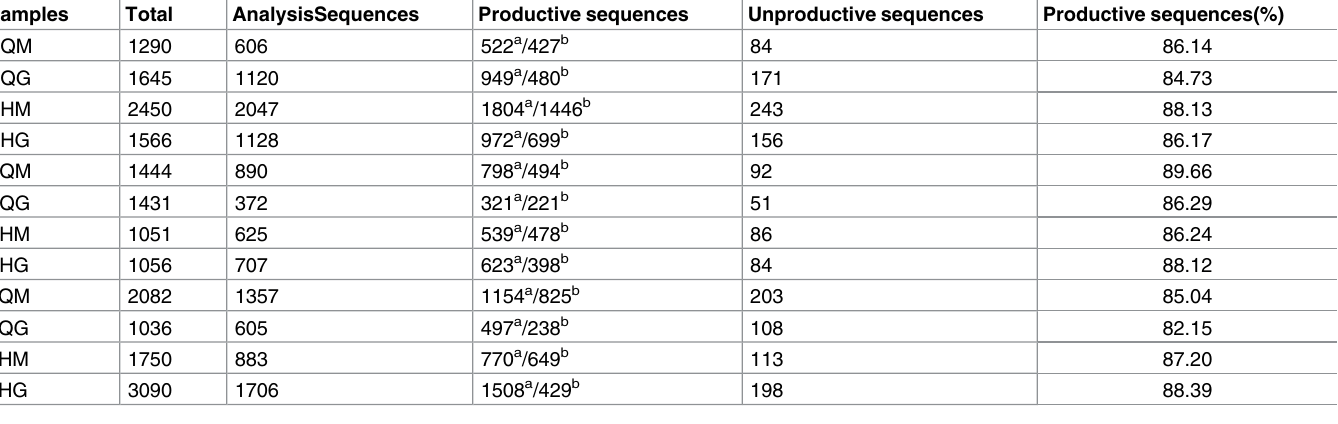
Table 3. Characteristics of sequence data.